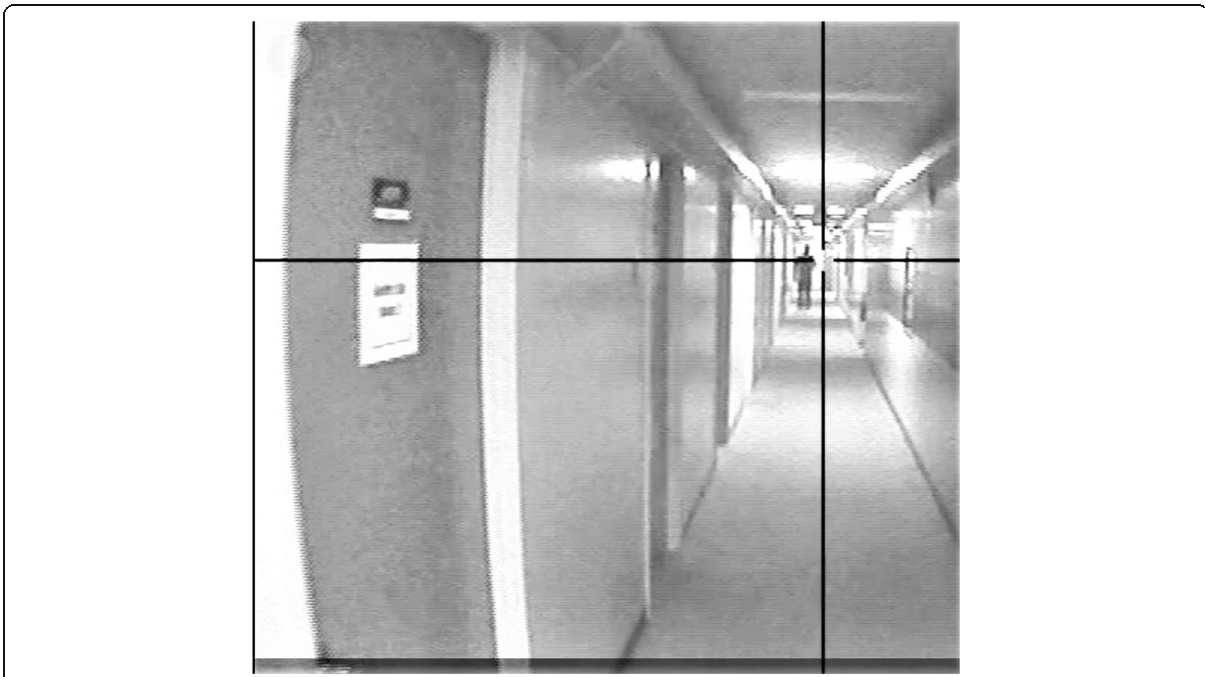
Fig. 1 Screen capture from a video of the hallway walk from the mobile eye tracker. The confederate is at the end of the hallway looking toward his or her own phone. The cross represents where the fixation was located. This was the start of the hallway. Seven doors are located in this hallway: five on the left and two on the right at the end of the